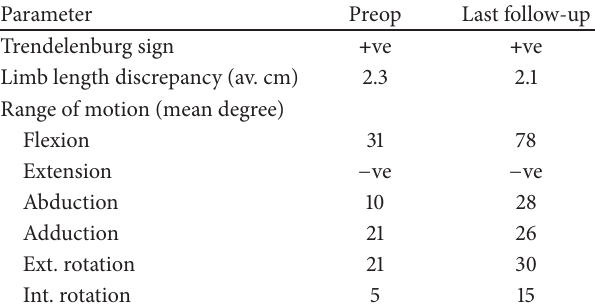
Table 2: Clinical